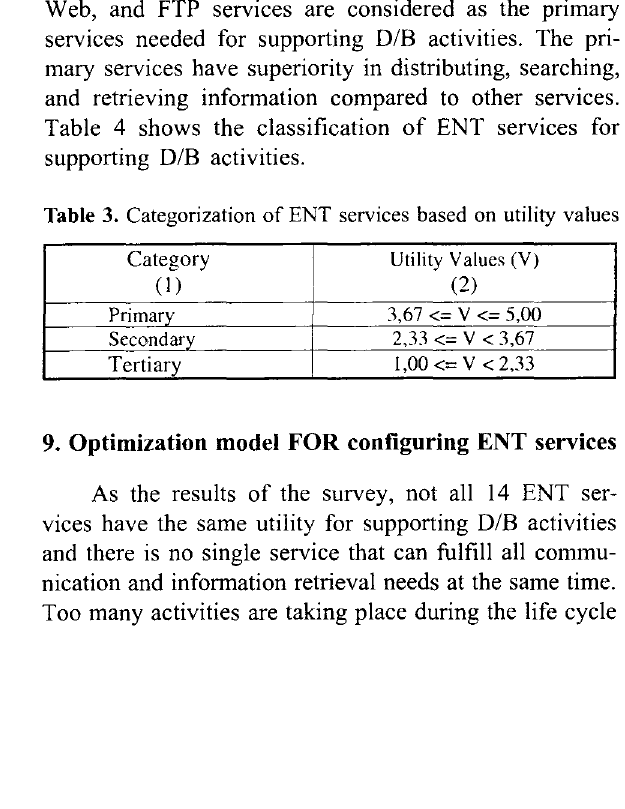
Table 3. Categorization of ENT services based on utility values